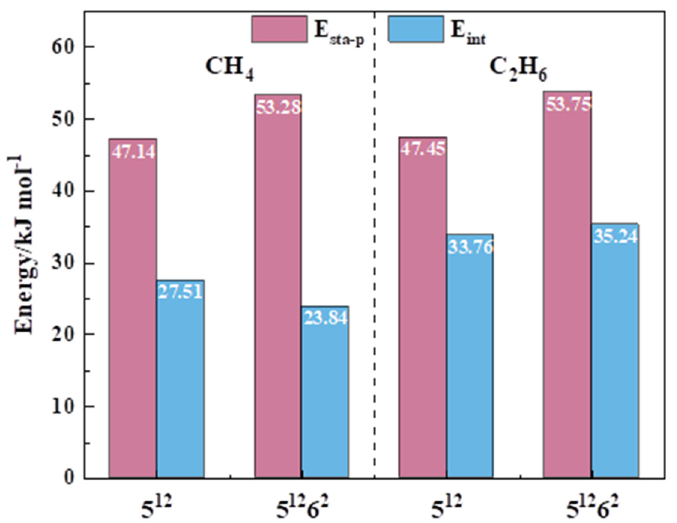
Figure 2. The stabilization energy per H 2 O molecule (E sta-p , kJ mol − 1 ) and interaction energy (E int , kJ mol − 1 ) of CH 4 and C 2 H 6 guest molecules in small (5 12 ) and large (5 12 6 2 ) cages.